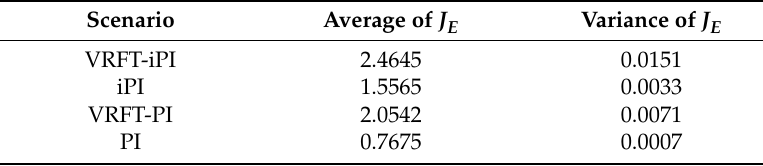
Table 2. Objective function values in experimental case study (2).